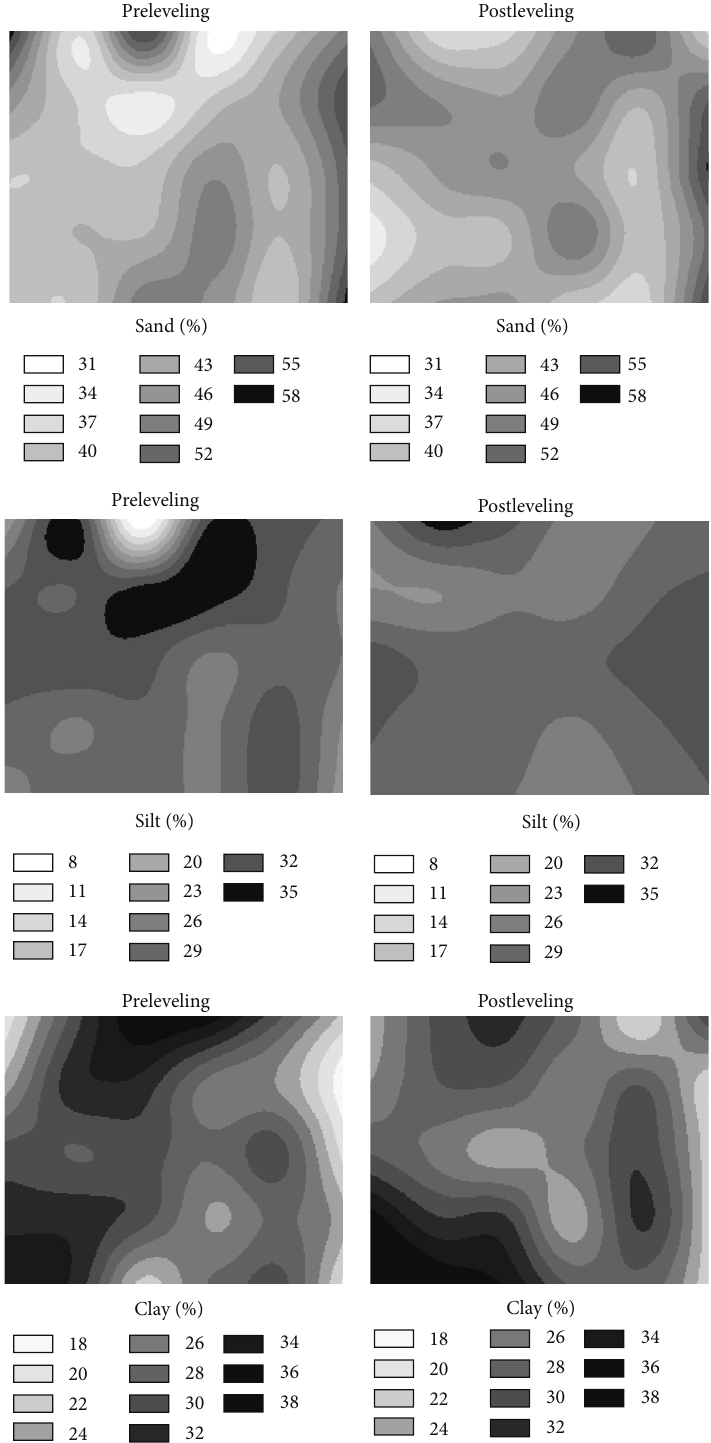
Figure 4: Pre- and post-leveling spatial distributions of soil particle-size fractions in surface soil (0 −